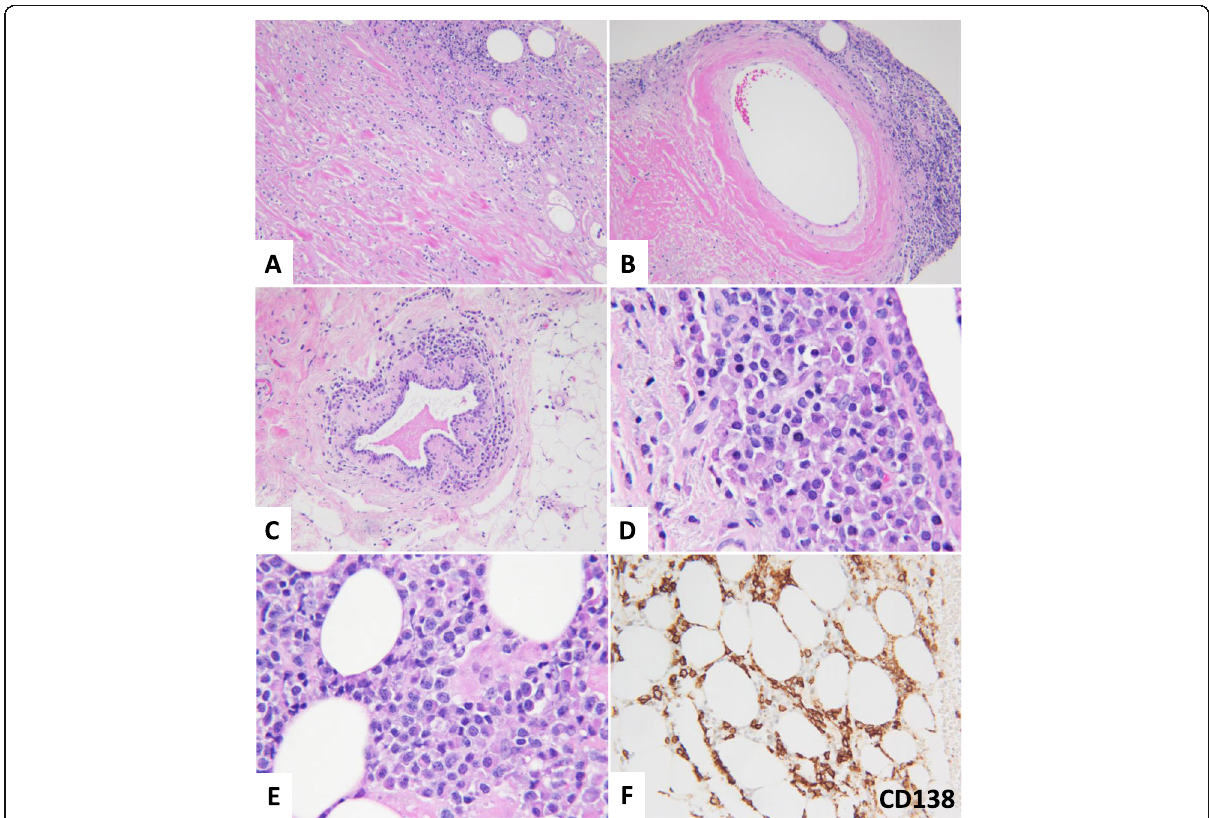
Fig. 1 Histological manifestations of lupus mastitis. a Panniculitis (upper right) with adjacent hyaline fat necrosis (lower left). b Perivascular inflammation with fibrinoid necrosis of the vascular wall. c Periductal inflammation. d High magnification of periductal inflammation and e panniculitis showing plasmacytic predominant infiltration. f CD138 immunostain of bone marrow biopsy revealed dense plasma cell population. (H&E, original magnification, × 100 [ a, b, c ], × 200 [ f ], × 400 [ d, e